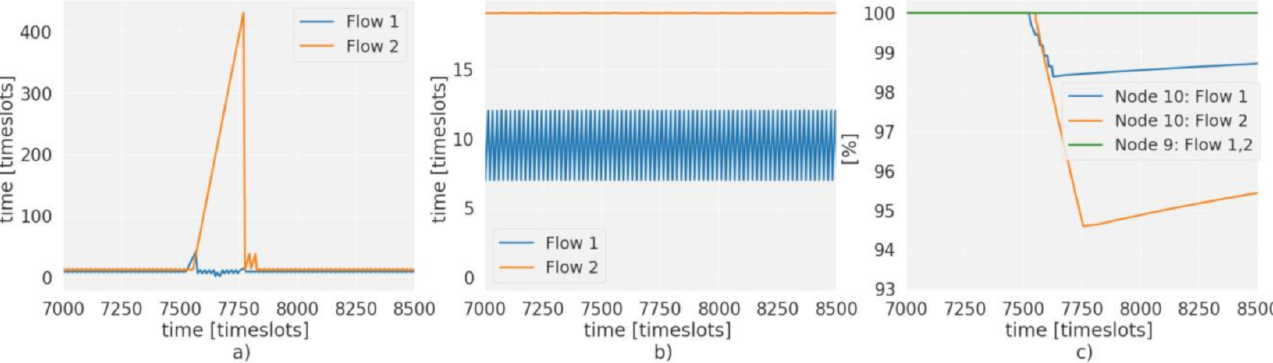
Figure 15. Effect of multiple transmission nodes in test topology; ( a ) Packet inter arrival time (node 10); ( b ) Packet inter arrival time (node 9); ( c ) Packet delivery